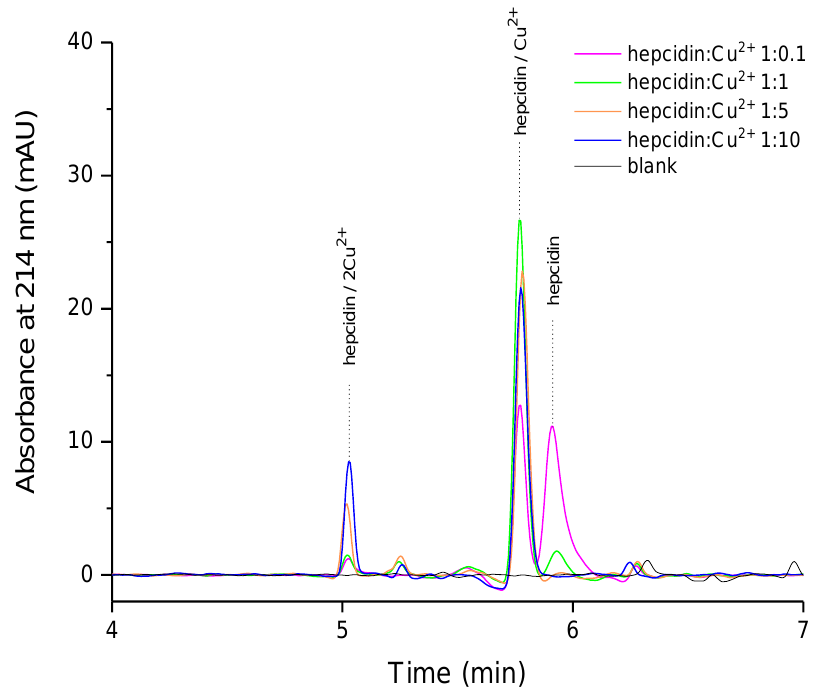
Figure 2. The influence of molar ratio on hepcidin-copper complex behavior (high performance liquid chromatography (HPLC) separation, mobile phase A: H 2 O/NH 3 100/0.1 v / v , pH = 11, B: ACN/H 2 O/NH 3 90/10/0.1, concentration of hepcidin-25 of 50 mg/L (18 µM)).